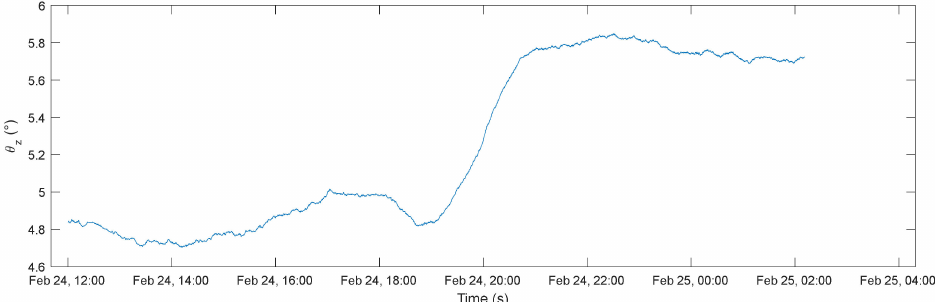
Figure 12. Angle φ z estimated from the accelerometer output and exploiting Equation (1) during the